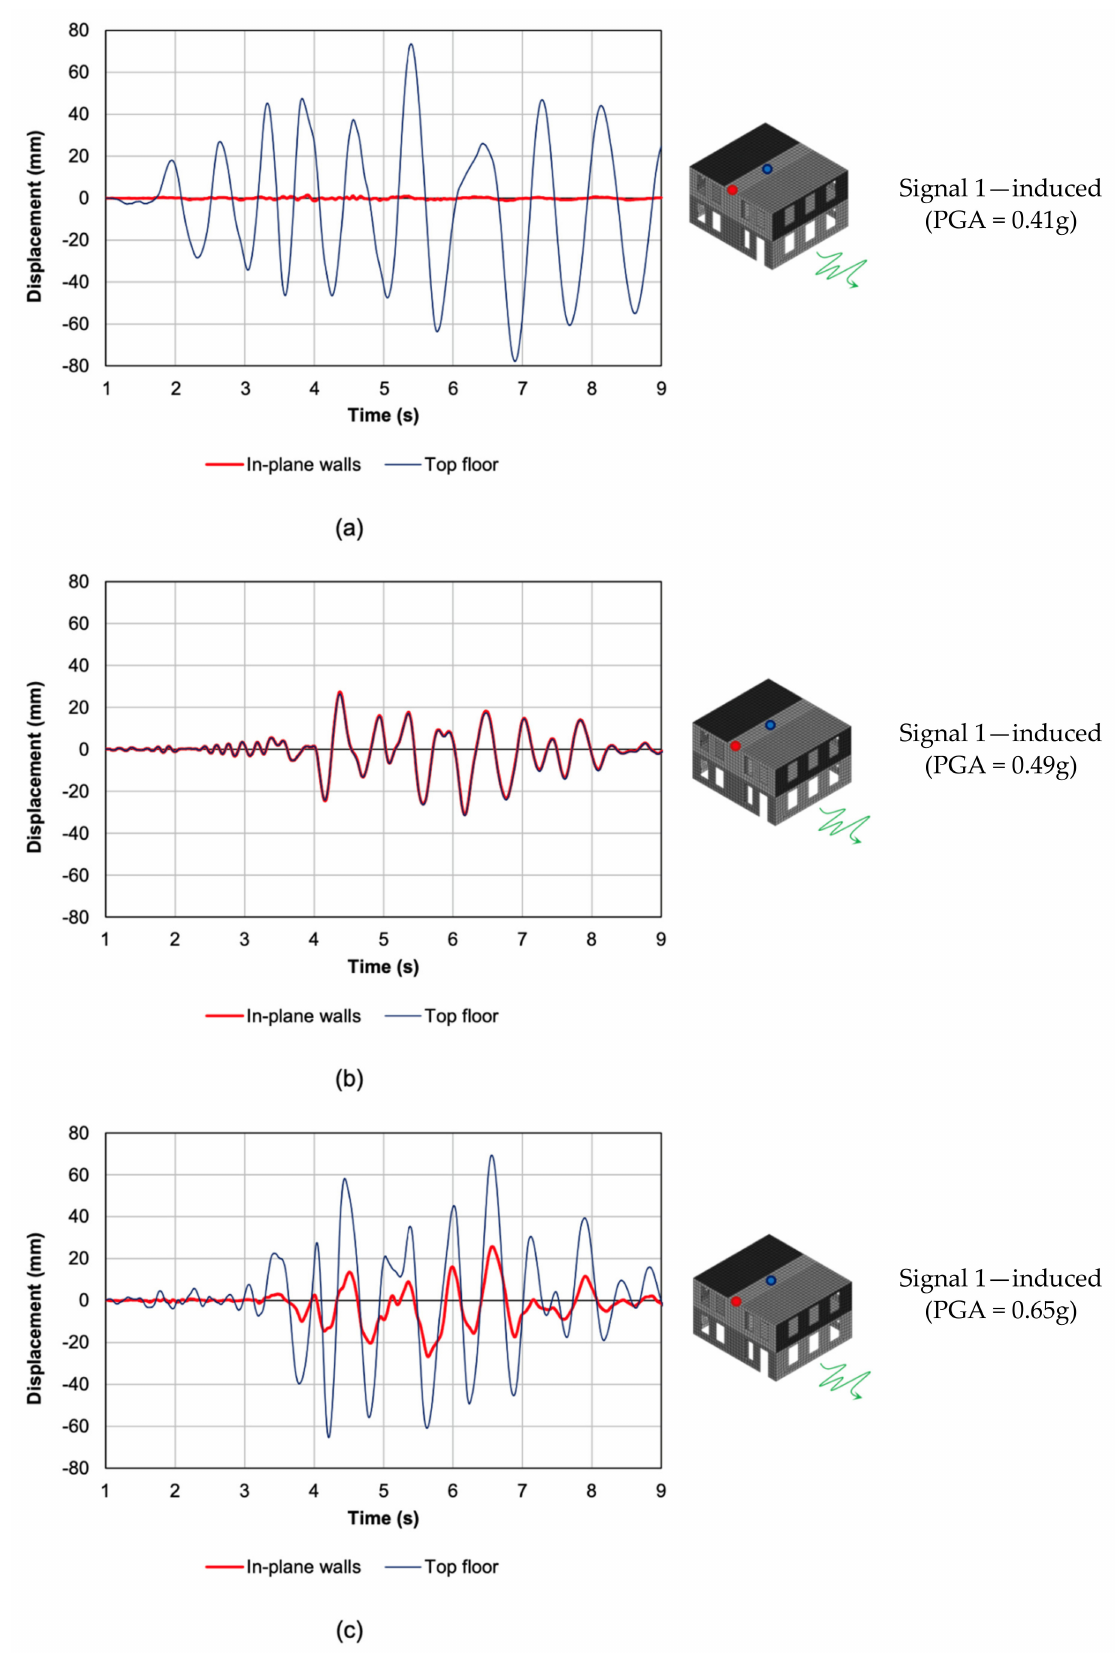
Figure 19. Examples of top floor and in-plane wall displacement time–histories for configurations B2-AB ( a ), B2-RC ( b ), and B2-PP ( c ) at